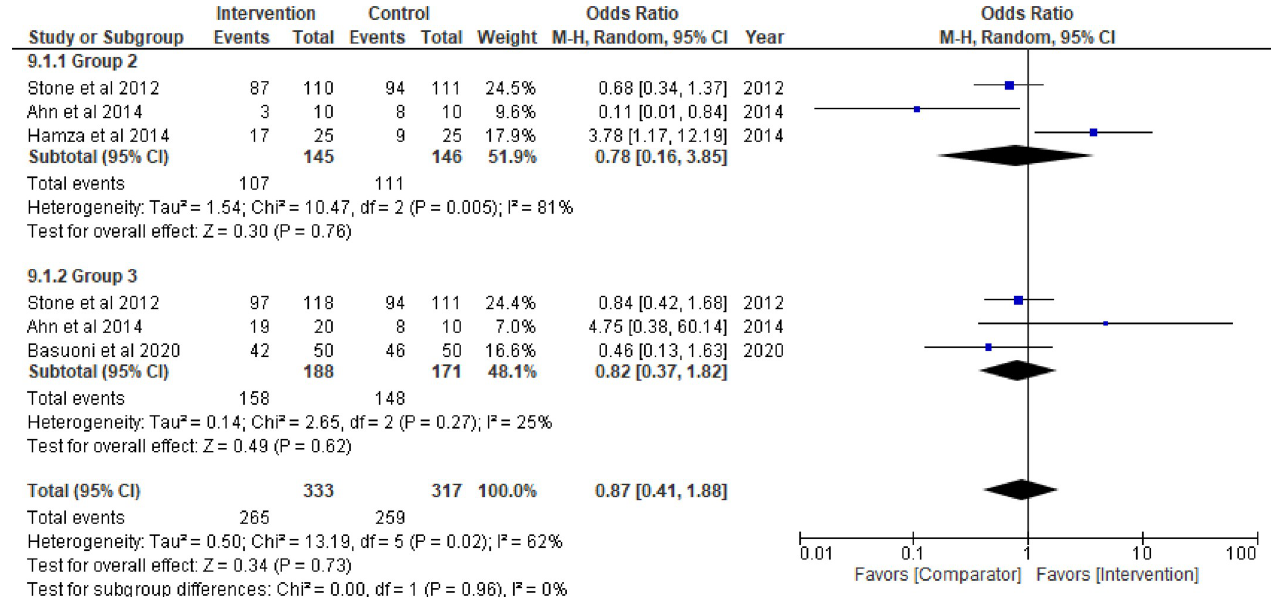
Fig 6. Myocardial blush grade 2/3. Group 2: Glycoprotein IIb/IIIa inhibitors (GPI); Group 3: GPI plus aspiration thrombectomy (No pooled data for Group 1).